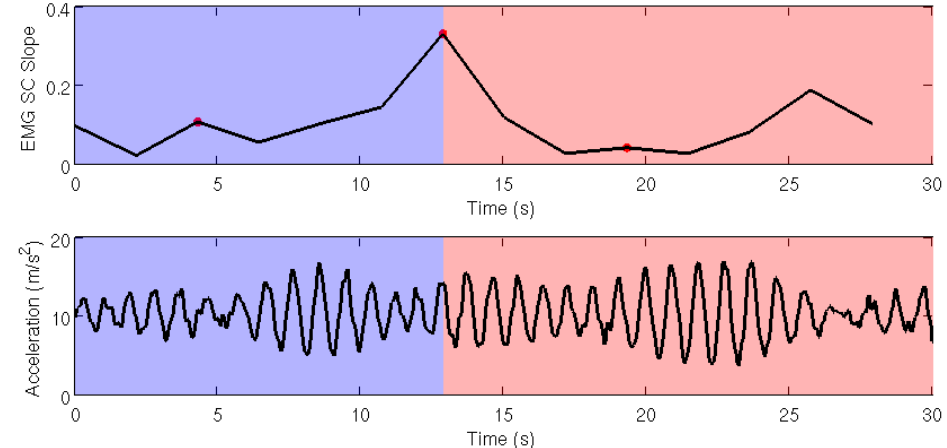
Figure 4. EMG SC slope from VM muscle signal (channel 3) and trunk acceleration during 30-STS. The cut-off time at second 12 corresponds to a descriptive acceleration value of 0.98 m/s 2. As far as acceleration was concerned, the highest acceleration was found in the Y axis, followed by Z, with X showing least acceleration. The value was higher when taking into account Nrv. Data are shown in Table 2. Table 2. Acceleration (m / s 2 ) in each axis and norm of the resultant vector (mean, SD).